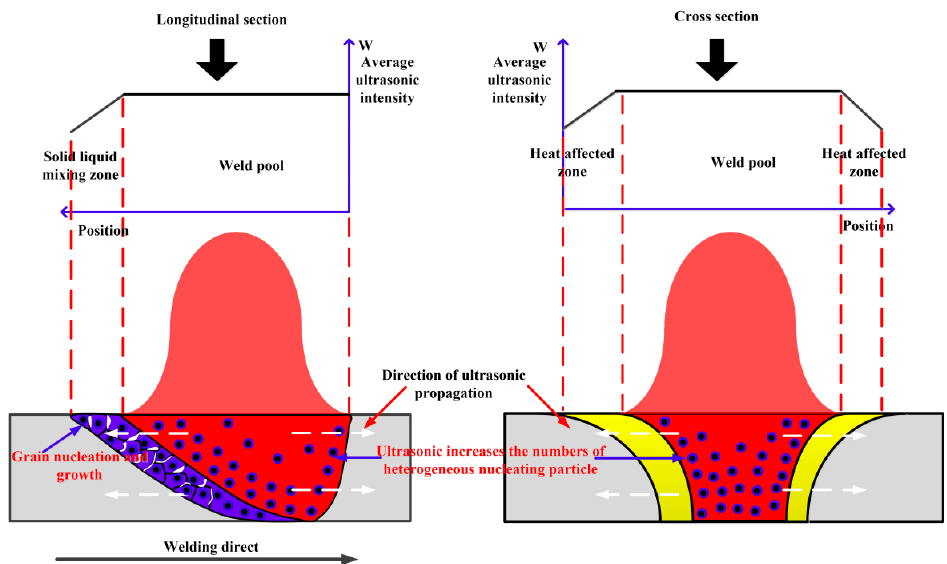
Figure 10. Diagram of arc-ultrasonic assisted microstructure refinement mechanism.